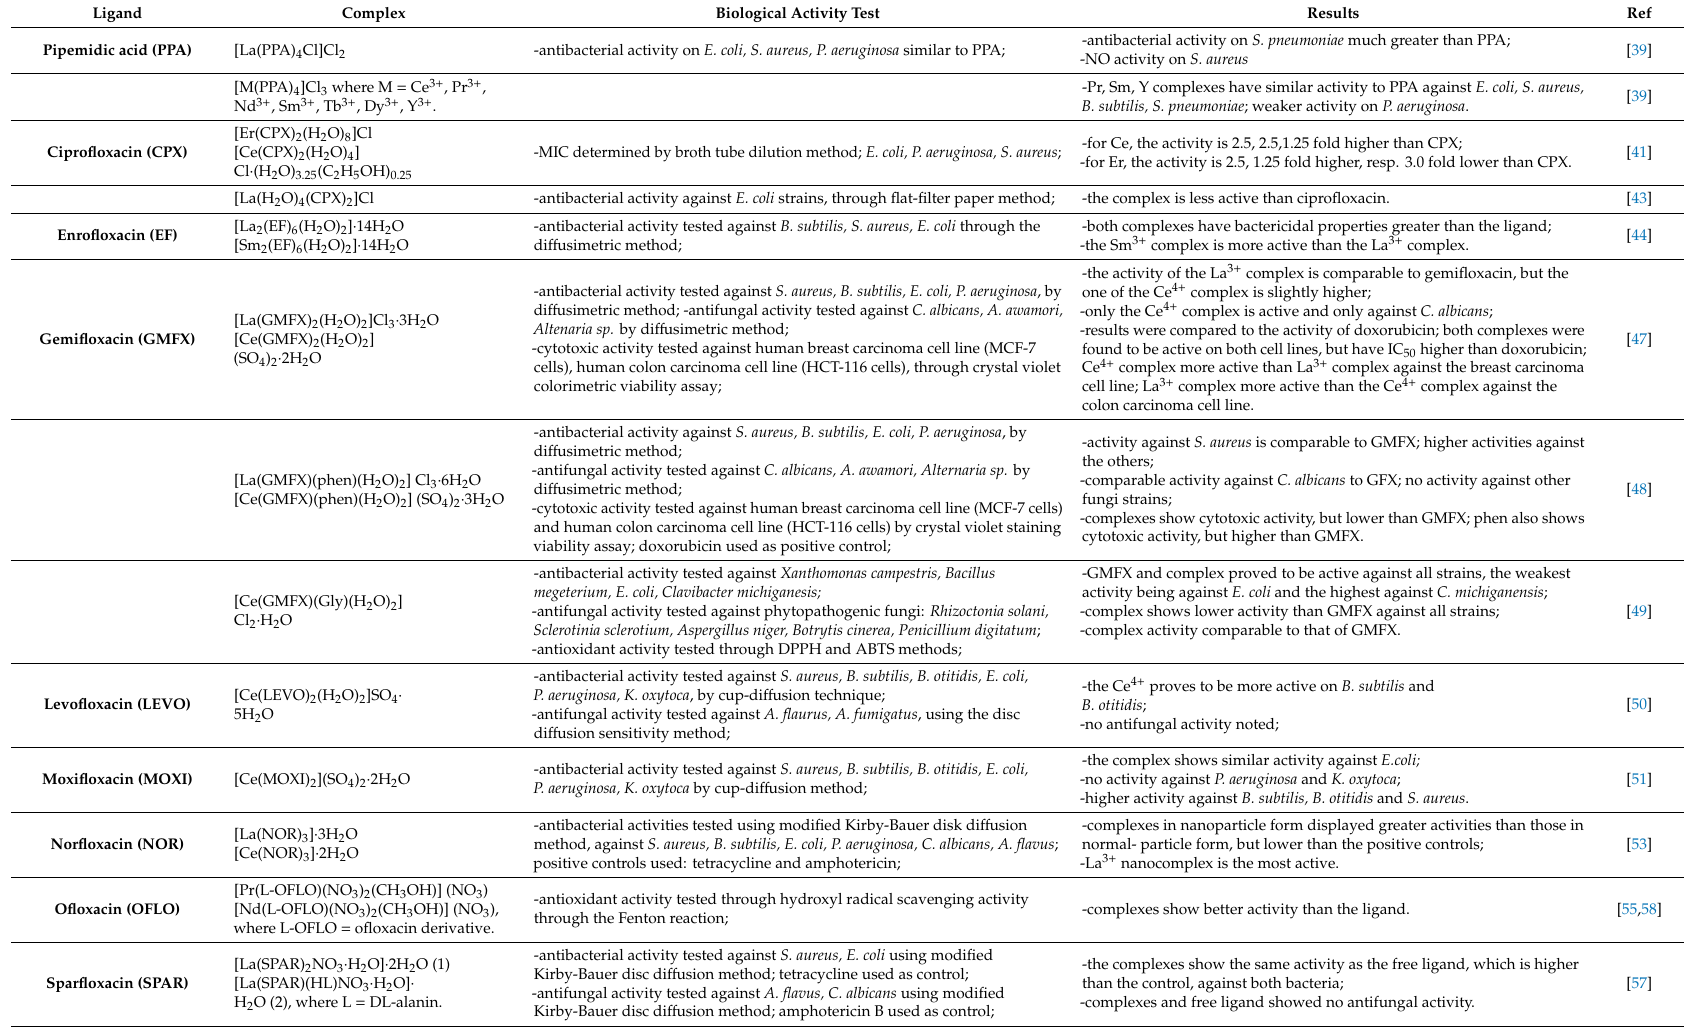
Table 2. Biological activity of quinolone complexes with lanthanide